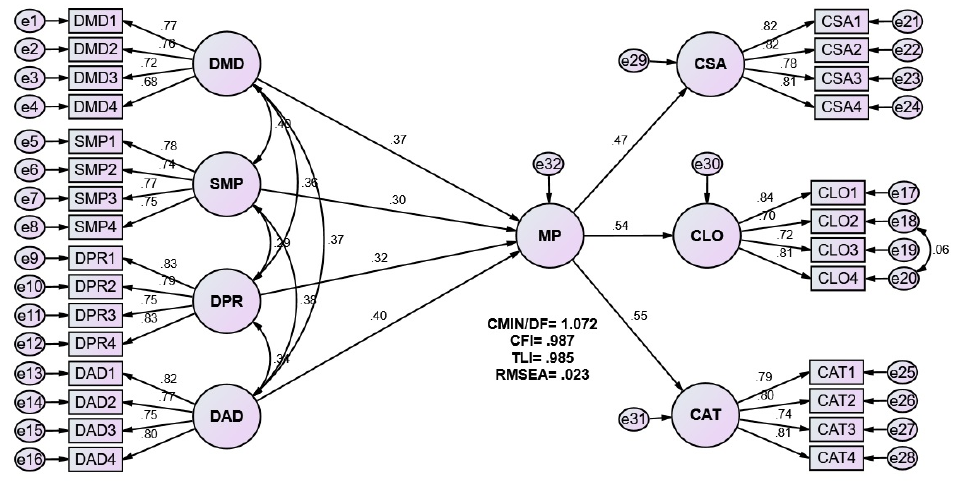
Fig. 1. Structural equation modeling results